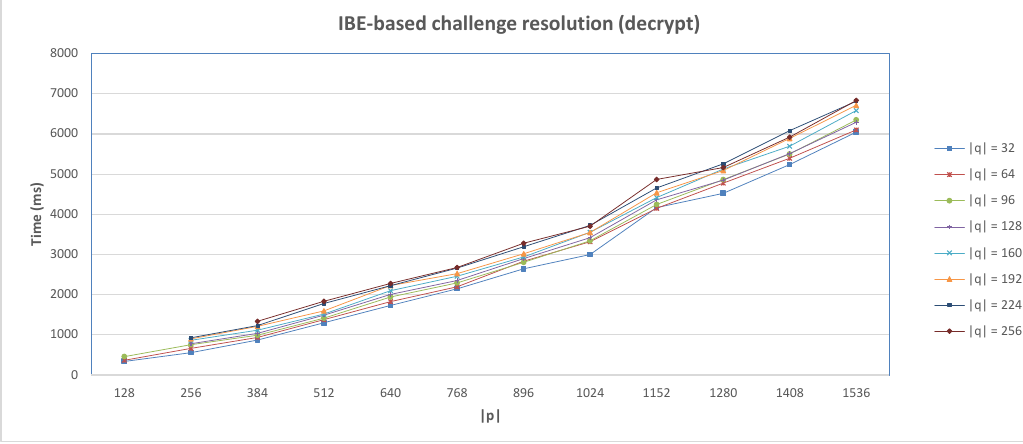
Figure 7. IBE-based Anonymous DCapBAC. Challenge resolution